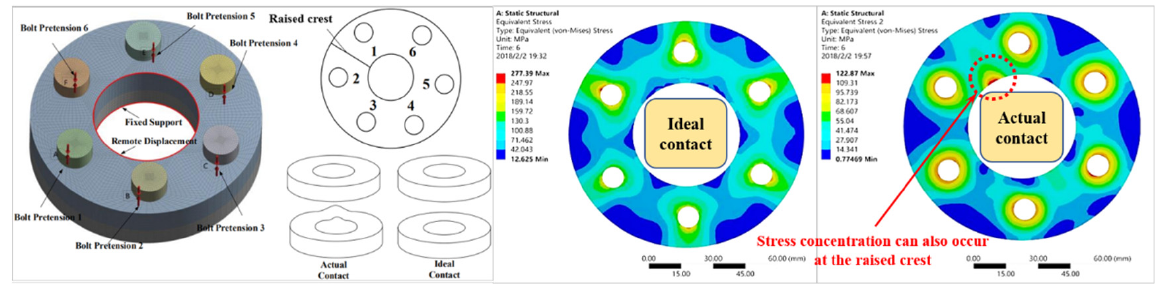
Figure 8. Comparison of stress clouds under ideal and actual contact conditions [49].